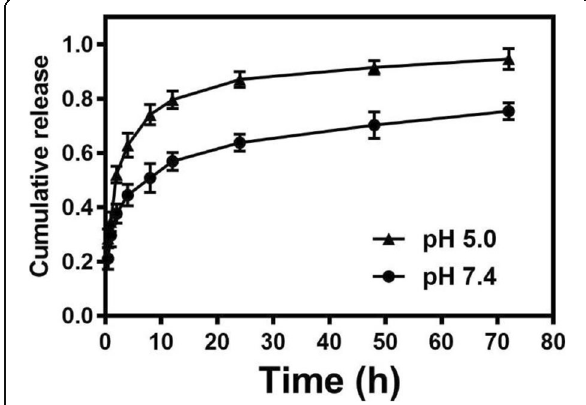
Fig. 5 In vitro release profiles of DXR from PLV/DXR in phosphate buffered saline at pH 7.4 vs 5.4 at different times after